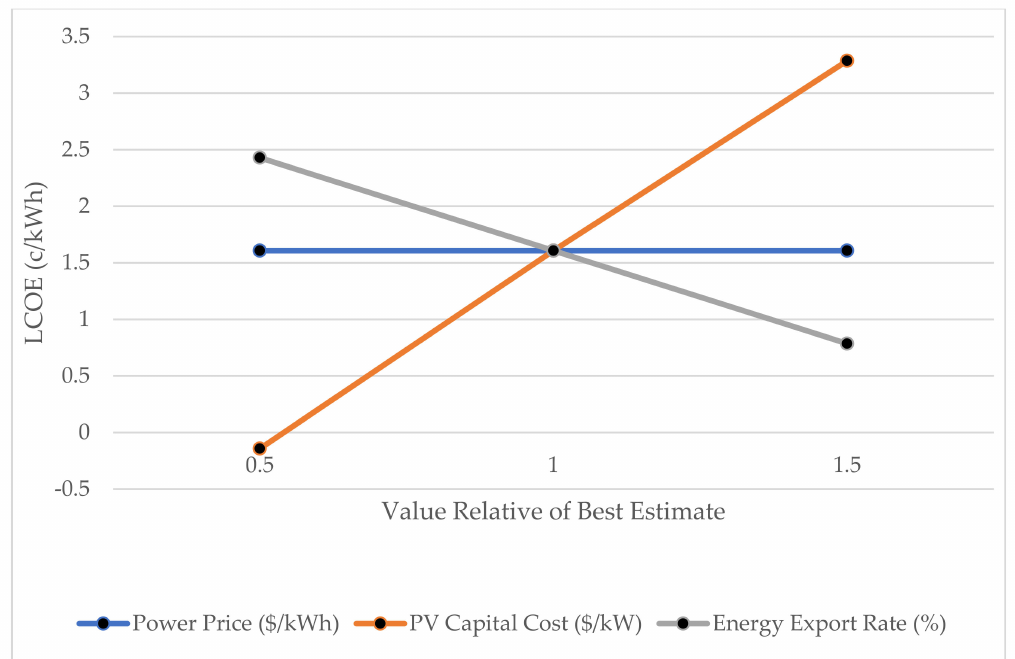
Figure 20. Sensitivity Analysis of PV On-grid Scenario